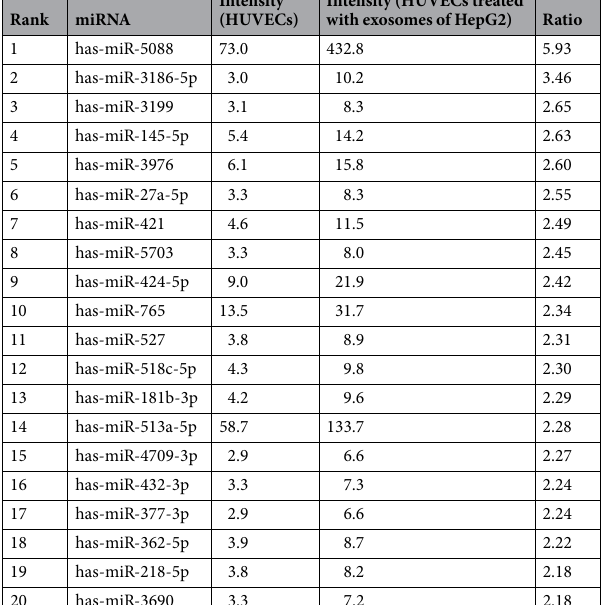
Table 4. Top20 up-regulated microRNAs derived from HUVECs treated with exosomes of HepG2 cells. Ratio: Intensity of miRNA derived HUVECs treated with exosomes of HepG2/Intensity of miRNA derived from